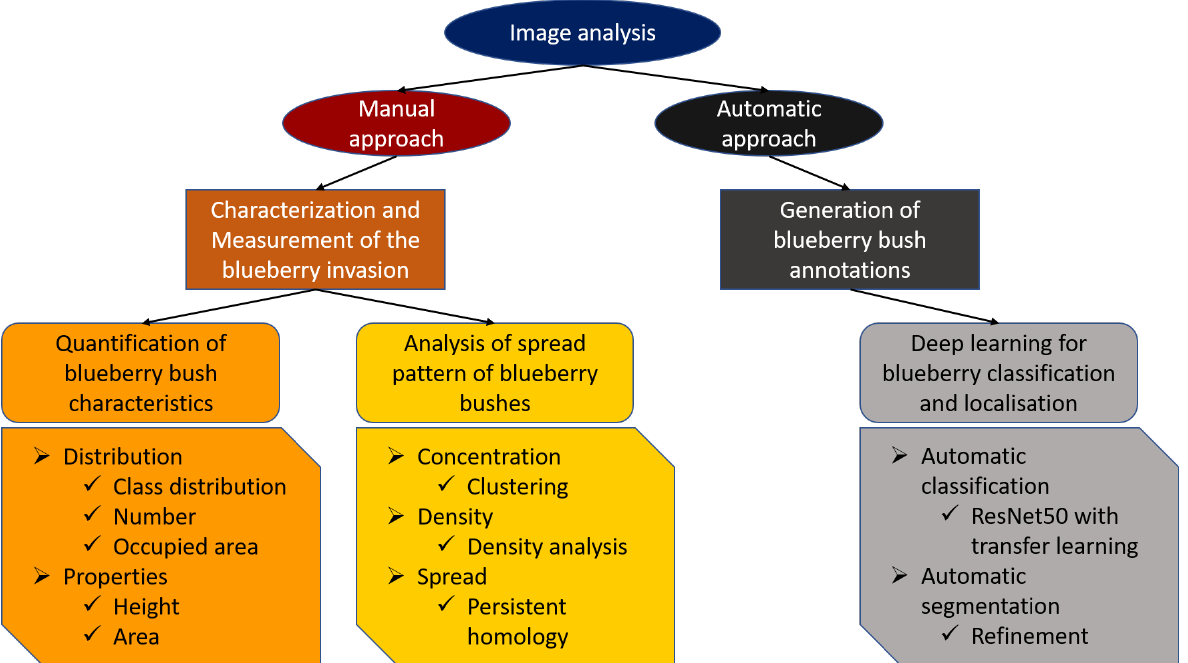
Figure 3. Image analysis workflow. Consists of two parts, the manual approach using manual annotation, GIS and persistent homology, and the automatic approach while using deep learning and segmentation to analyse the blueberry